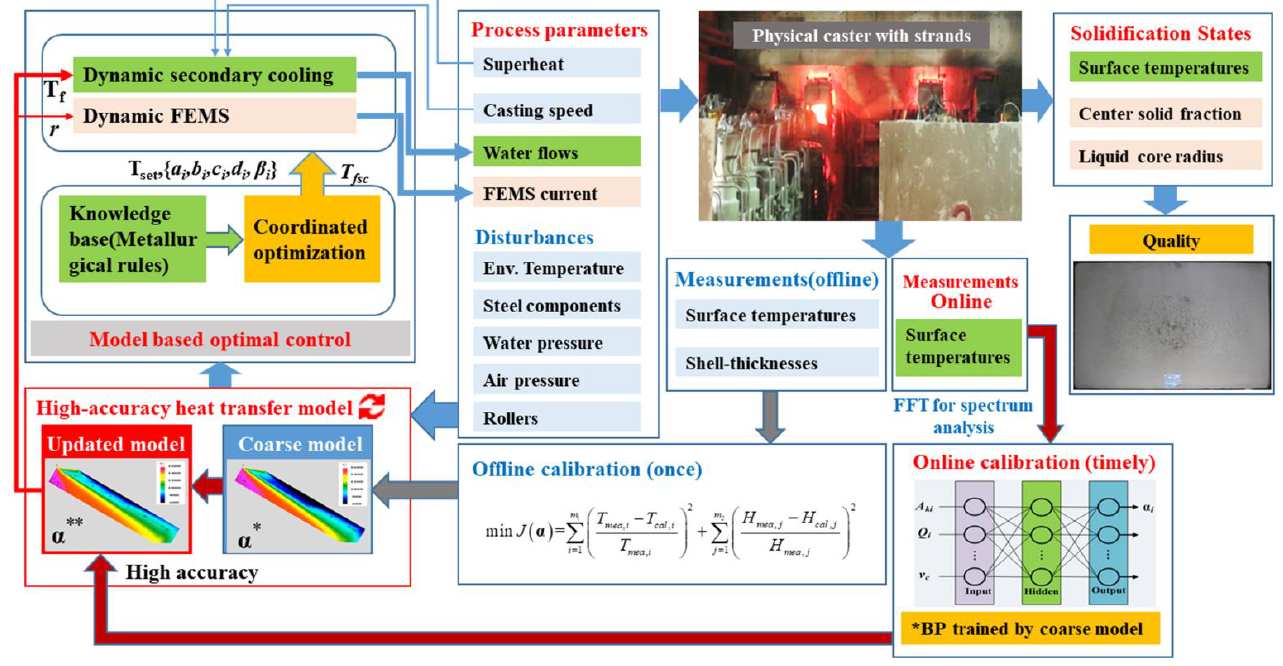
Figure 2. Intelligent optimal control strategy based on high-accuracy model.